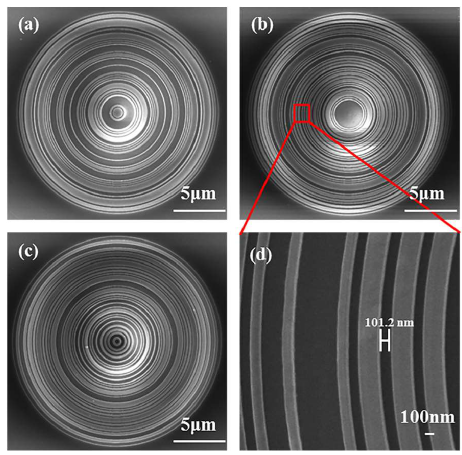
Figure 3. SEM diagrams of ( a ) SOL #1; ( b ) SOL #2; ( c ) SOL #3; and ( d ) the enlarged view of SOL #2.